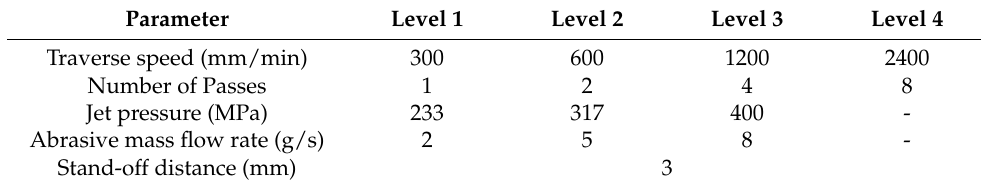
Table 2. Process parameters and their levels.